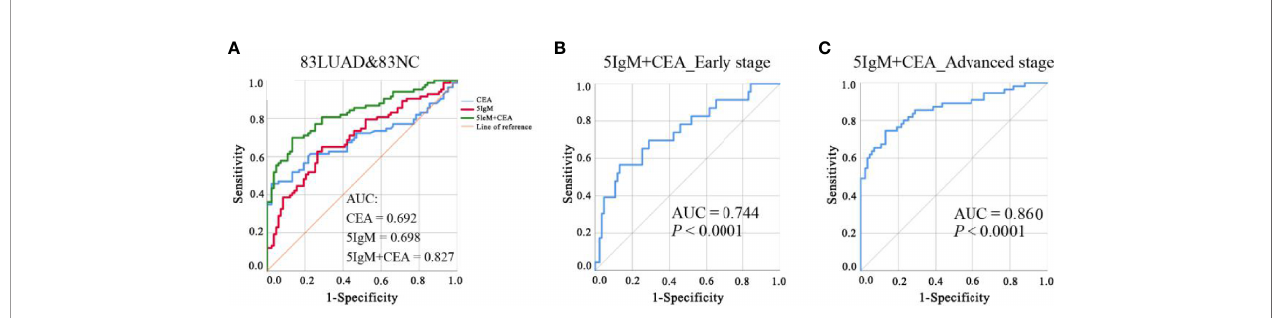
FIGURE 6 | (A) ROC analysis of CEA alone, fi ve IgM autoantibodies alone, and the combination of fi ve IgM and CEA for the detection of LUAD from NC. (B, C) . ROC analysis of the diagnostic model for LUAD patients at different stages of the disease. AUC, area under the receiver operating characteristic curve; CEA, carcinoembryonic antigen; LUAD, lung adenocarcinoma; NC, normal control; ROC, receiver operating characteristic.